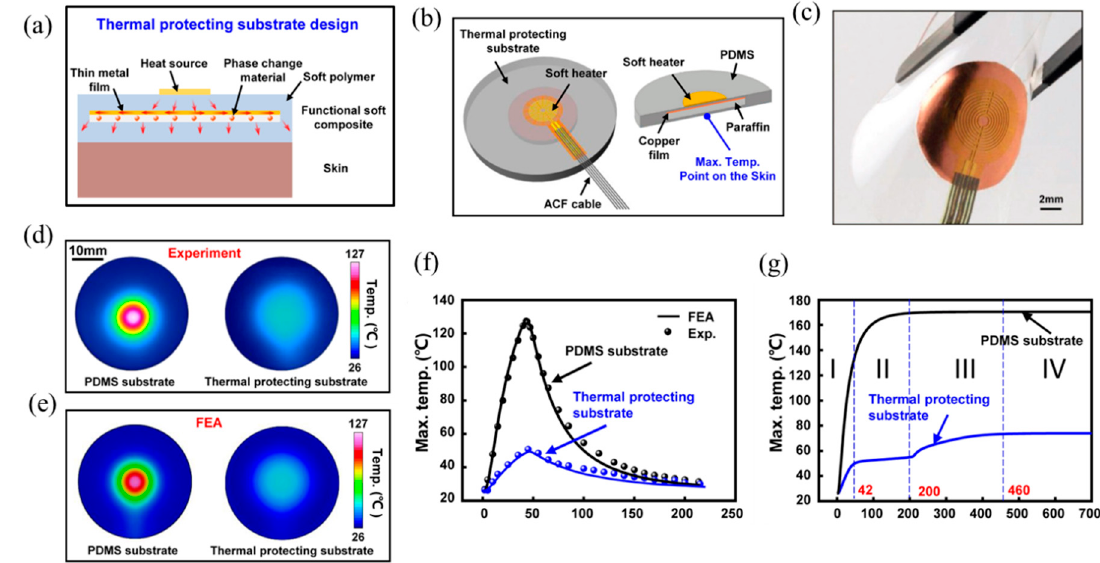
Figure 9. ( a ) Cross-sectional illustration of a skin-integrated wearable device with a functional soft composite substrate design [85]. ( b ) Schematic illustration of a wearable device consisting of a heat source on the functional soft composite substrate with the embedded paraffin as the phase change material and the Cu film on its top in PDMS [85]. ( c ) Optical image of a wearable device under bending deformation [85]. Temperature distributions on the bottom of the PDMS substrate and thermal protecting substrate from ( d ) experiments and ( e ) FEA after heated 40 s [85]. The maximum temperature on the bottom of the thermal protecting substrate versus time with ( f ) a heating duration of 40 s and ( g ) a long heating duration [85].